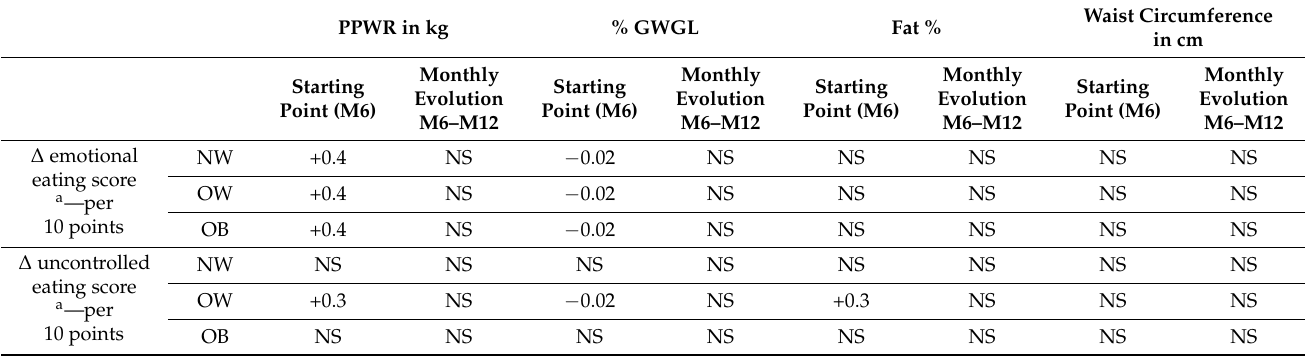
Table 4. Factors at six months postpartum in association with evolution of weight and body composition up to 12 months